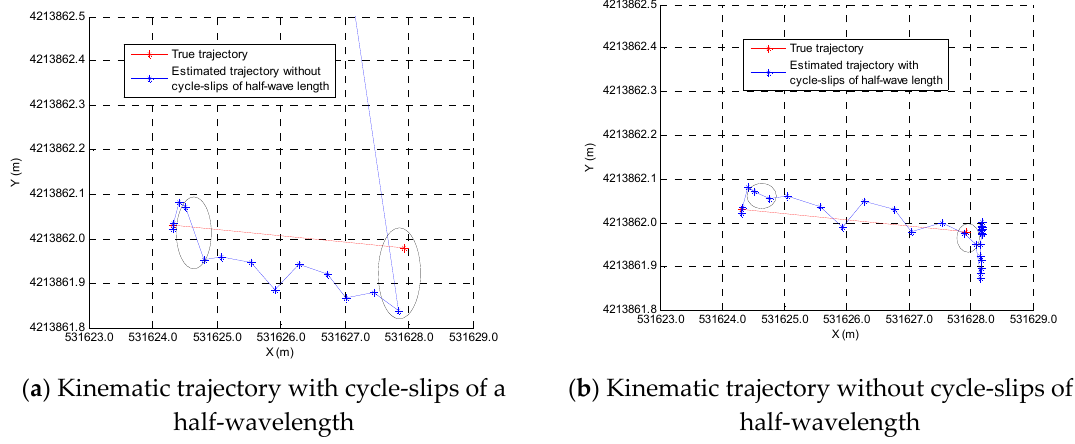
Figure 19. Kinematic trajectory with and without cycle-slips of a half-wavelength.